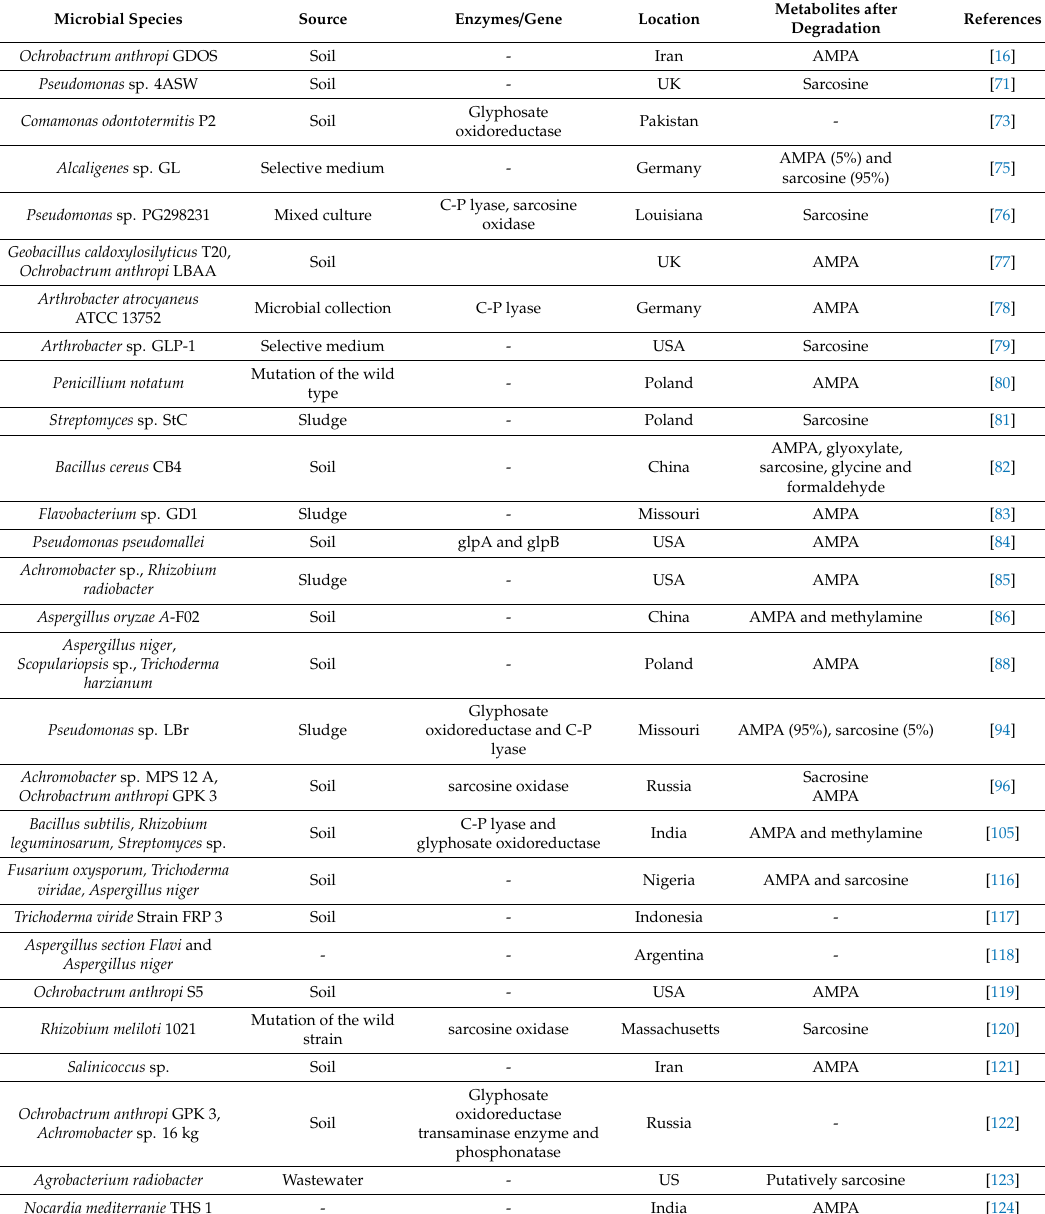
Table 1. A list of various microbial species responsible for glyphosate metabolism and enzymes responsible for degradation